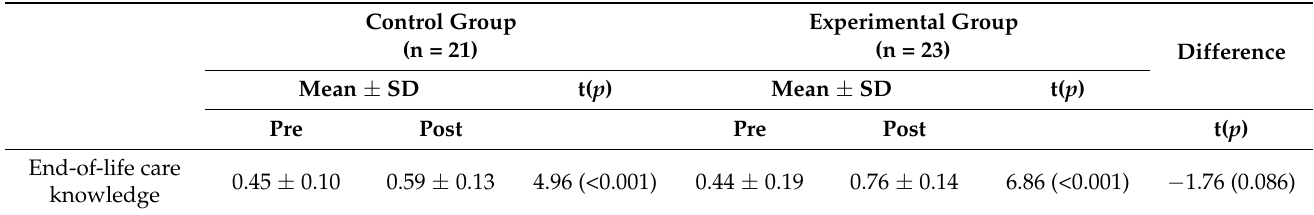
Table 2. Difference in the pre- and post-test scores of end-of-life care knowledge between the experimental group and control group.